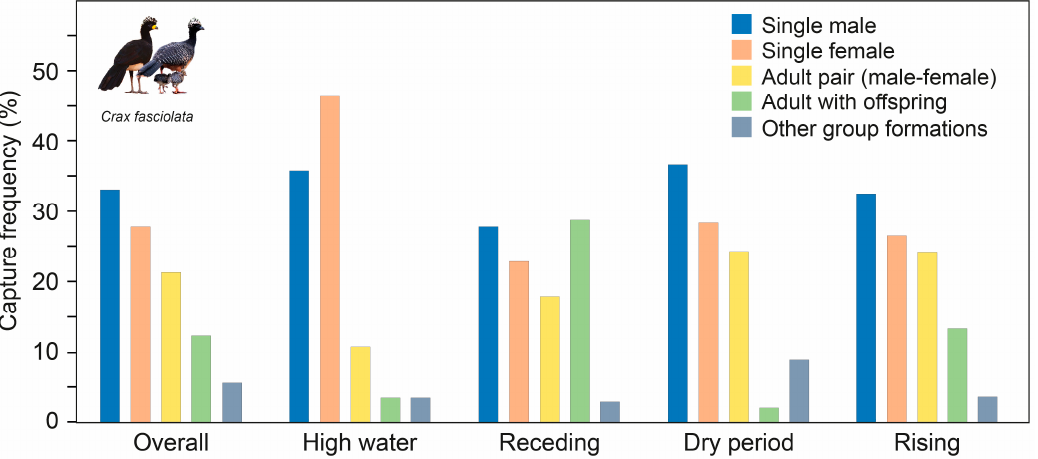
Figure 2. Proportion (%) of independent captures of Bare-faced Curassow ( Crax fasciolata ) (based on a 30 min independence interval) grouped by single female, single male, adult pair (male–female), adult with offspring, and other group formations for the overall study and for seasonal period defined by water regime (high water, receding, dry period, and rising) obtained between July 2015 and December 2017 in the Northern Pantanal (Mato Grosso, Brazil).